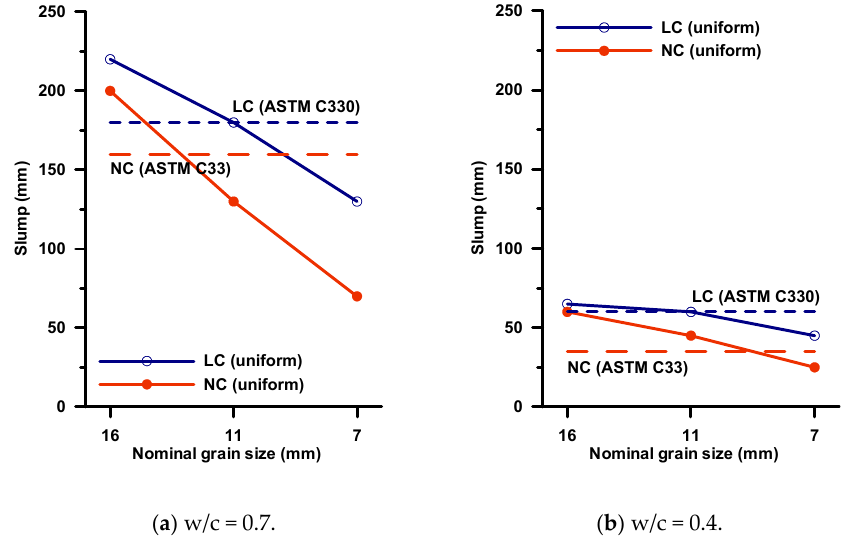
Figure 5. Slump of normal-weight concrete (NWC) and lightweight aggregate concrete (LWAC).